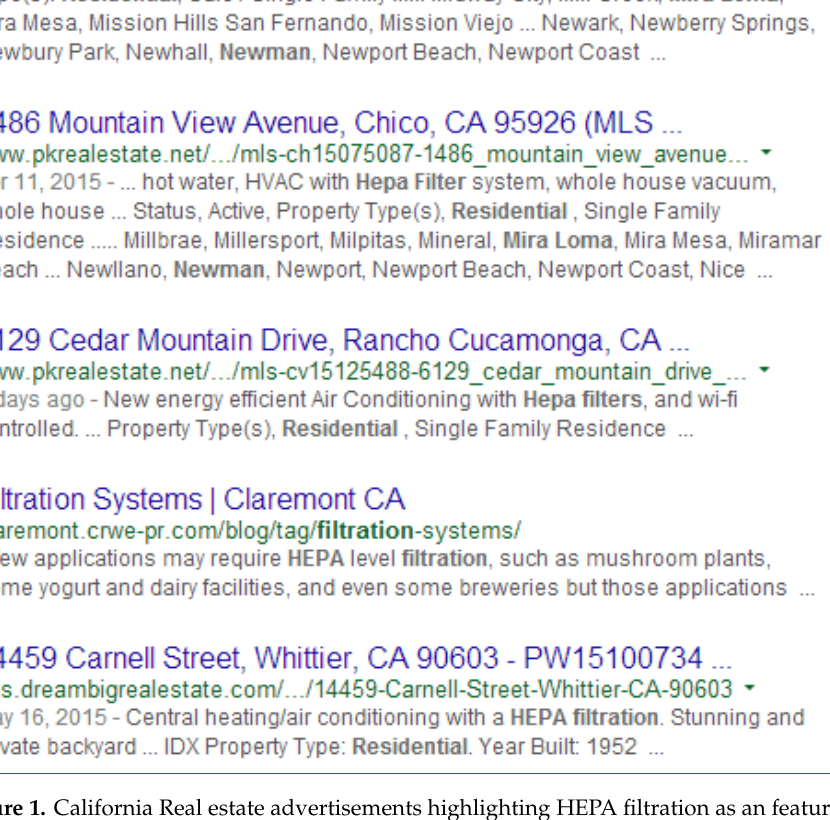
Figure 1. California Real estate advertisements highlighting HEPA filtration as an feature.